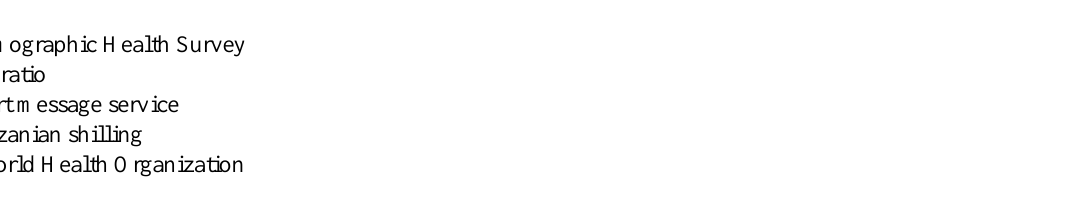
DHS: Demographic Health Survey OR: odds ratio SMS: short message